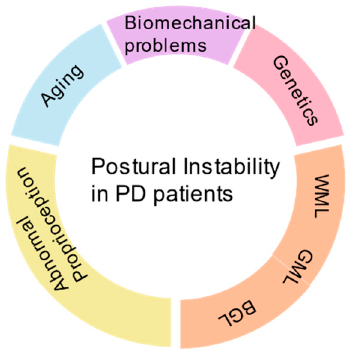
Figure 1. Overview of causative factors of postural instability (PI) in Parkinson’s disease (PD) patients.